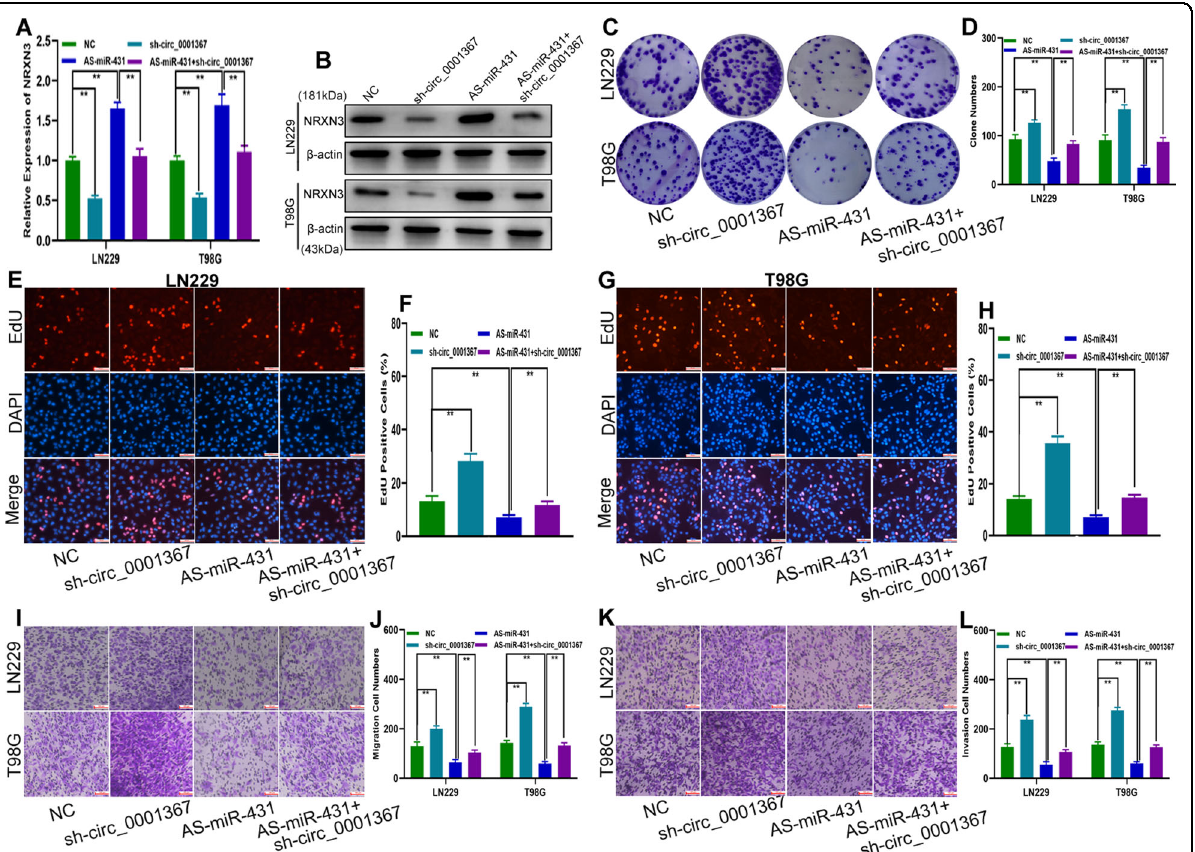
Fig. 8 Circ_0001367 inhibited the glioma malignancy phenotype by targeting the miR-431/NRXN3 axis. A, B qRT-PCR and western blot analysis of NRXN3 expression in LN229 and T98G cell lines transfected with sh-circ_0001367, miR-431 inhibitors or sh-circ_0001367 + miR-431 inhibitors. C , D Clone formation assay to evaluate the proliferation of LN229 and T98G cells transfected with sh-circ_0001367, miR-431 inhibitors or sh-circ_0001367 + miR-431 inhibitors. E – H EdU assay to measure the proliferation of LN229 and T98G cells transfected with sh-circ_0001367, miR-431